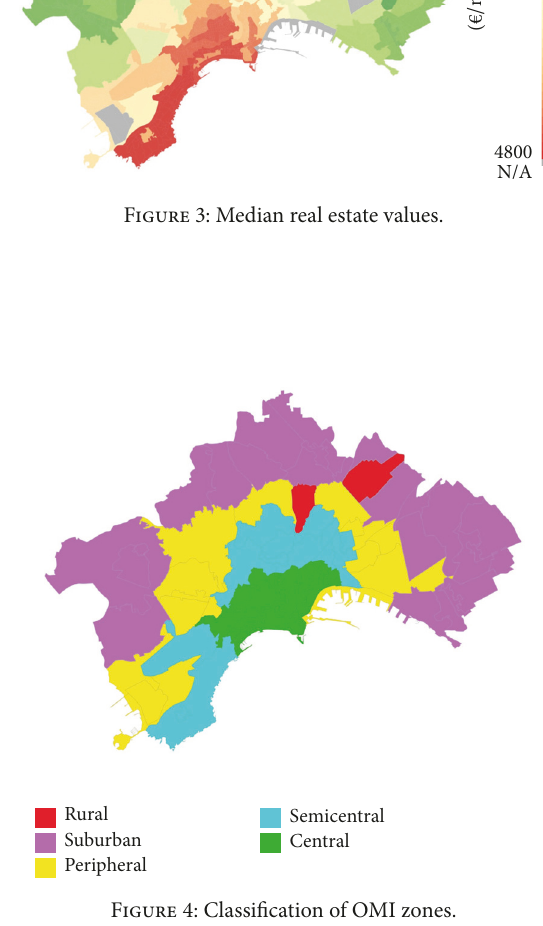
Figure 4: Classification of OMI zones.